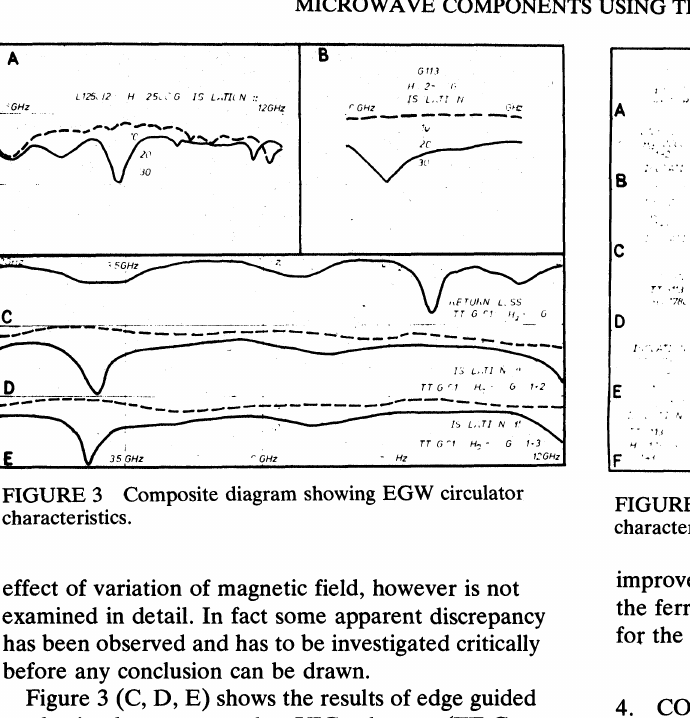
FIGURE 3 Composite diagram showing EGW circulator characteristics.